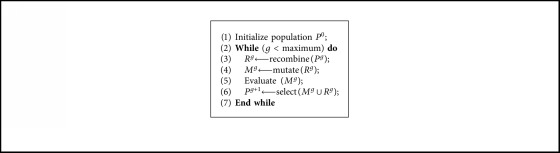
Pseudocode of GA.